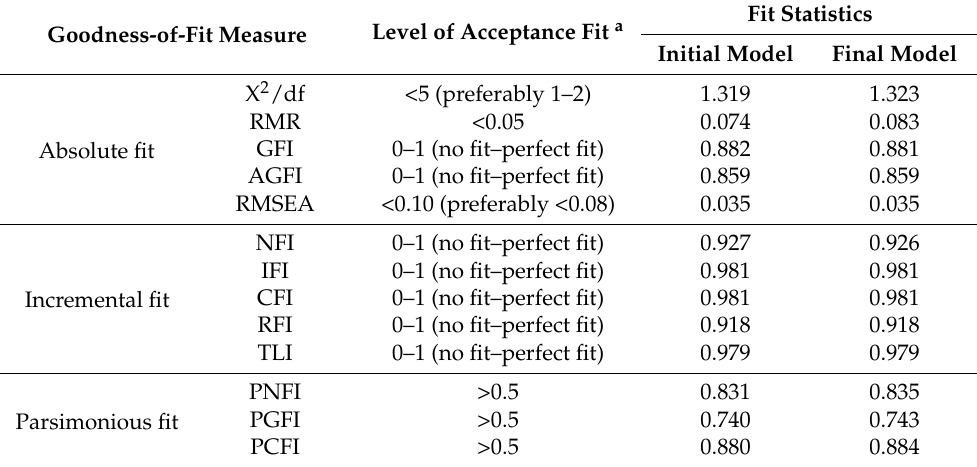
Table 5. Goodness-of-fit of the model.